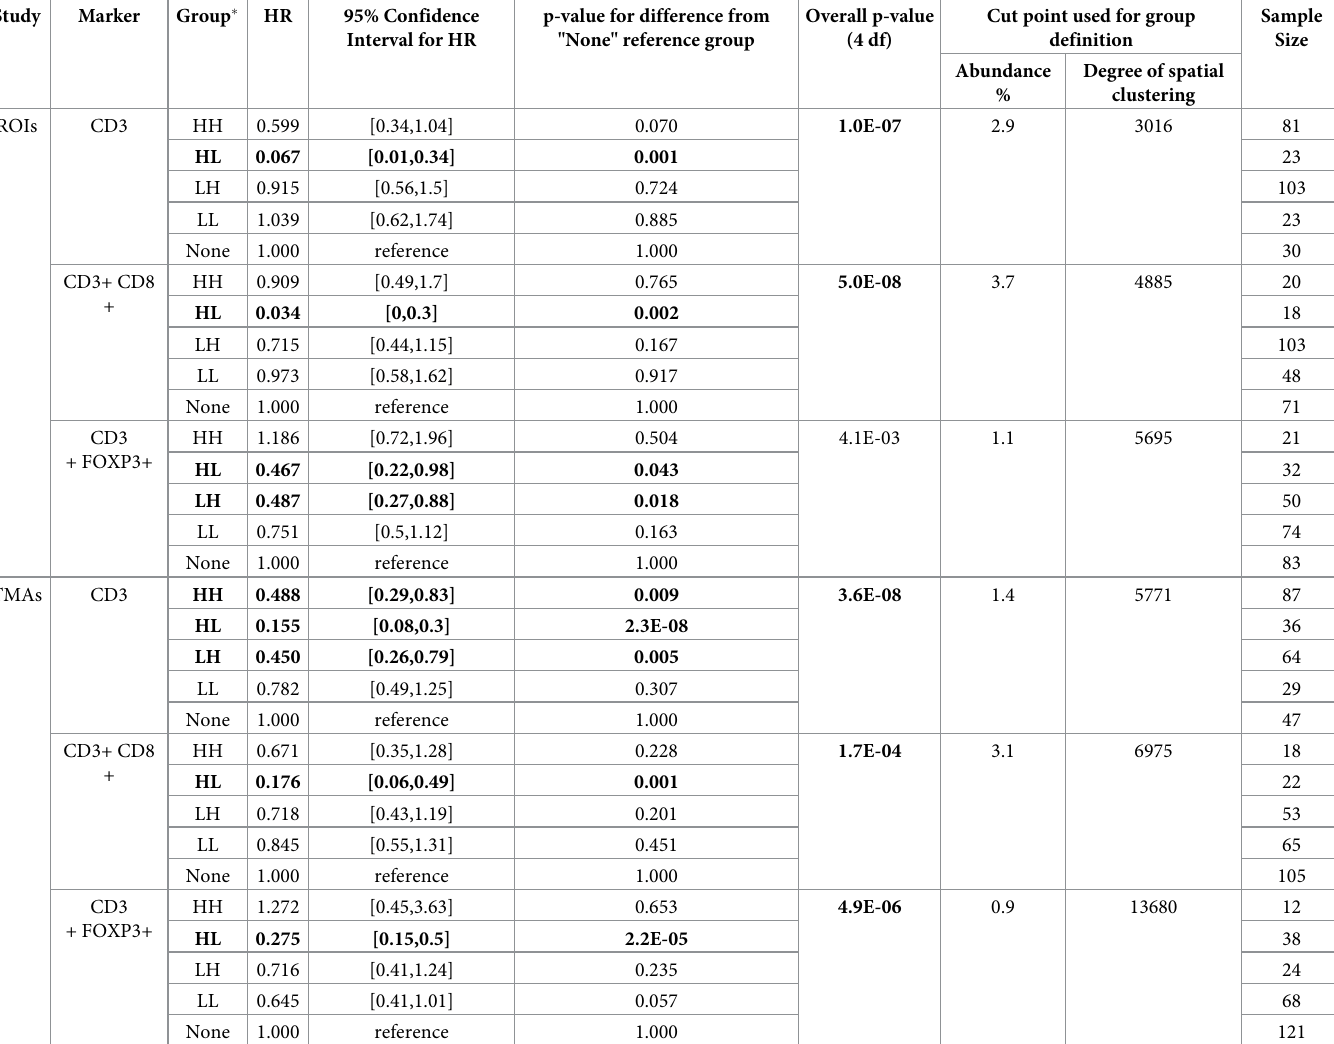
Table 1. Results from survival analysis of the immune marker abundance and spatial clustering from the ROIs involving 93 subjects with 260 ROIs and TMAs involving 94 subjects and 263 cores. Degree of spatial clustering based on permutation-based estimate of CSR. Models were adjusted for age at diagnosis and stage. Group None is reference group. The overall p-value is the joint association of the five categorial variable based on immune abundance and spatial clustering on overall survival. Study